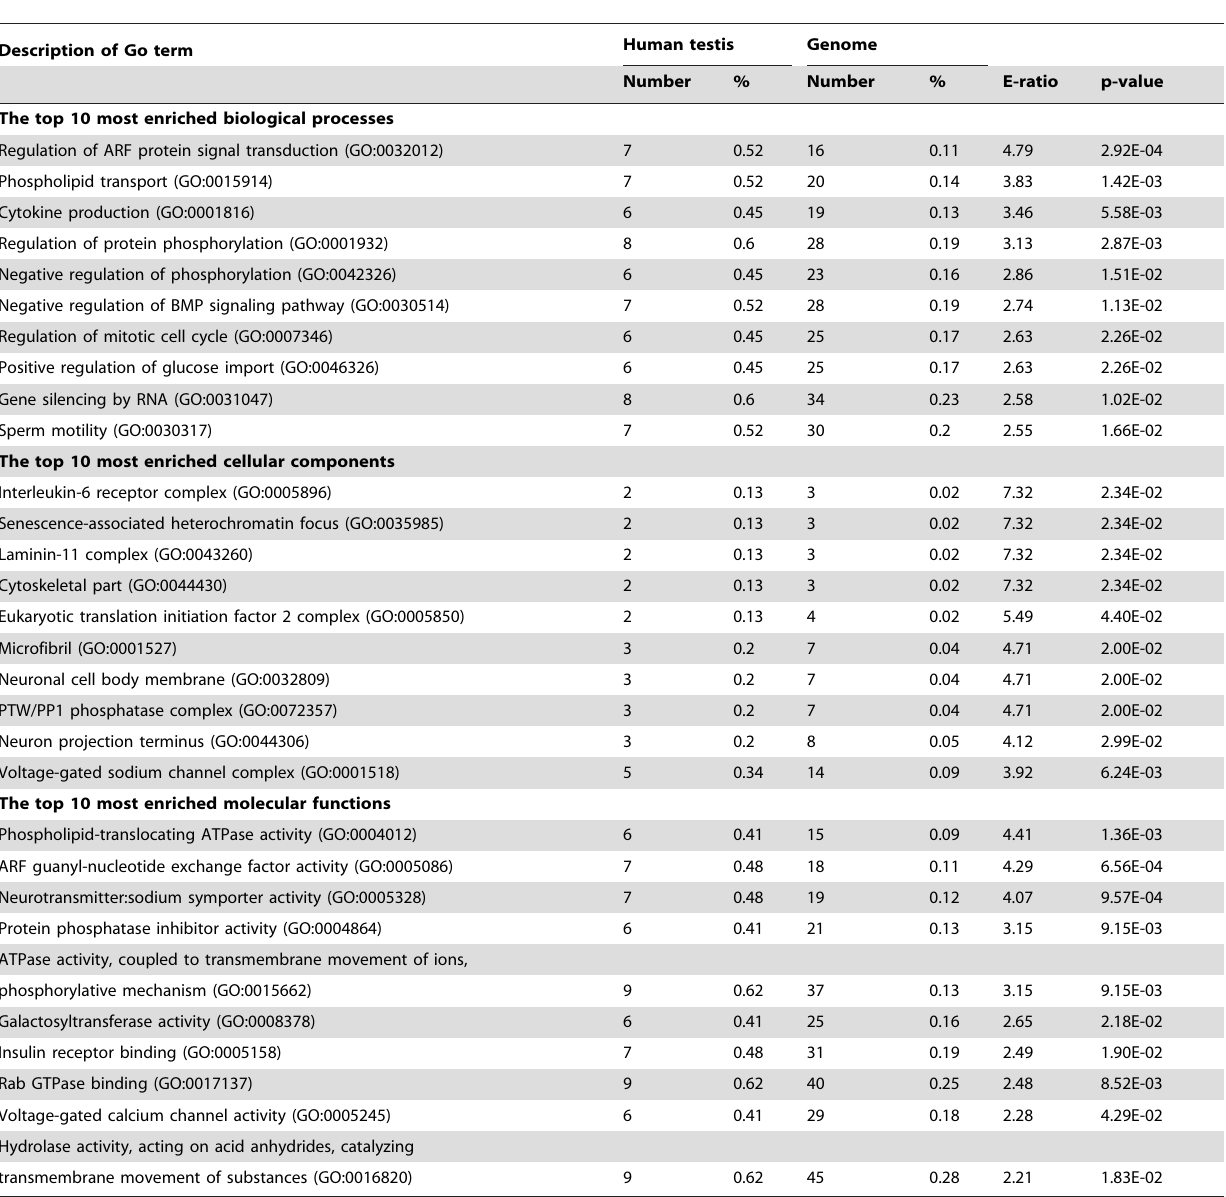
Table 3. The top 10 most enriched GO terms of biological processes, molecular functions and cellular components in predicted targets of 10 abundant known